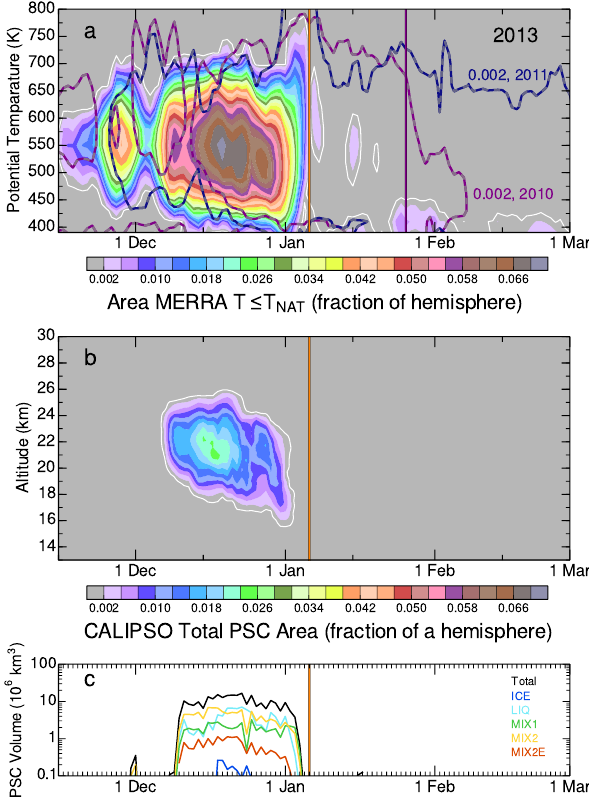
Figure 3. (a) Time series of the area poleward of 30 ◦ N with T ≤ T NAT as a function of potential temperature in 2012/13 from MERRA (color fill; the white contour shows a value of 0.001, indi- cating a very small nonzero value); area is expressed as fraction of a hemisphere, with a color bar range from 0 to 0.07. The overlaid purple and blue contours show the 0.002 contour (which is at the boundary between grey and lavender in 2012/13) in 2009/10 and 2010/11, respectively; purple and orange vertical lines show the be- ginning dates of the SSWs in 2010 and 2013, respectively. (b) Time series of CALIPSO total PSC area; format is as in (a) but with only 2012/13 values. (c) Time series of the total volume of different types of PSCs observed by CALIPSO in 2012/13 (see